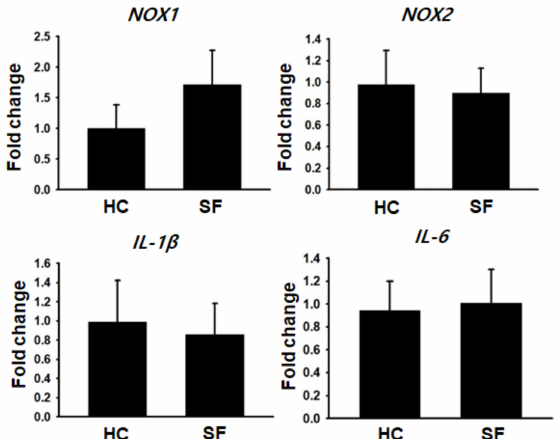
Figure 4. Expression of genes related to ROS generation and inflammation in tumor tissues from mice in the HC and SF groups. Comparison of relative NOX1, NOX2, IL-1 β , and IL-6 mRNA expression levels in tumors from mice in the HC and SF groups. Data are presented as the mean ±